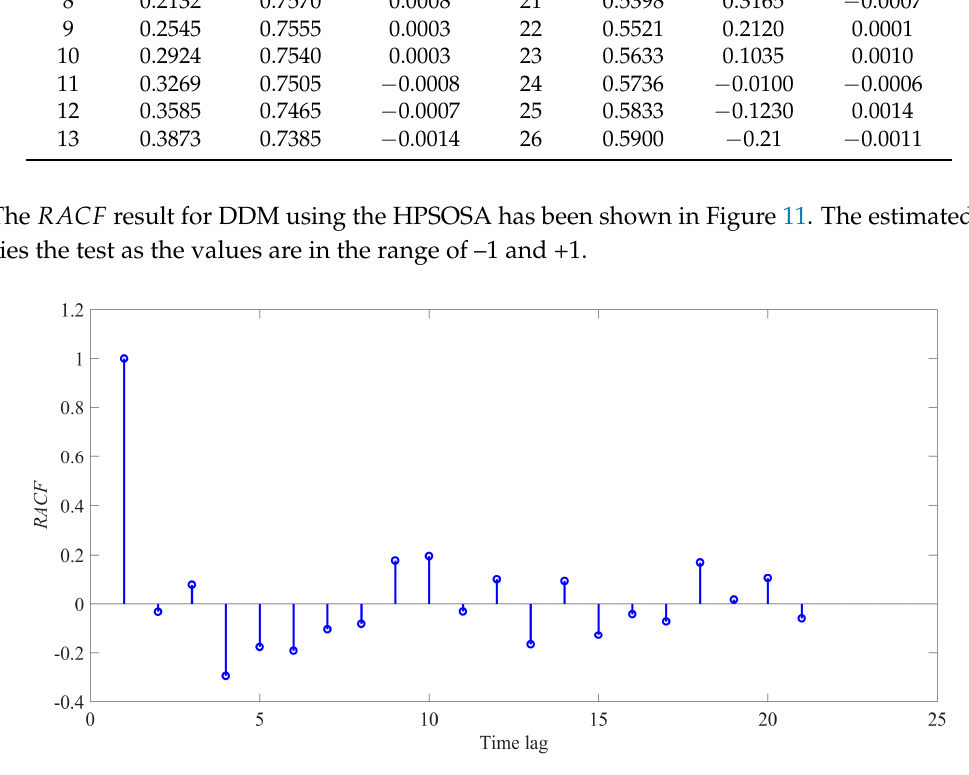
Figure 11. RACF results for DDM.